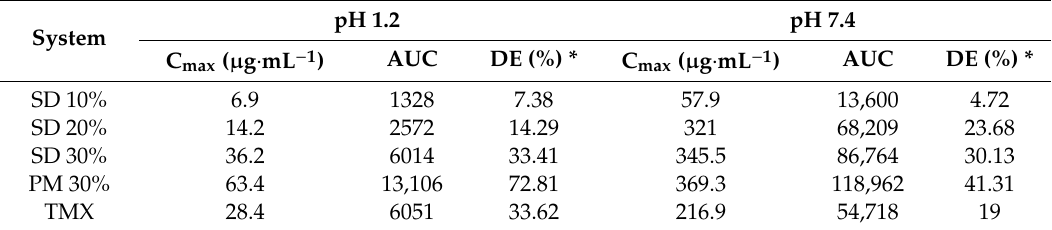
Table 1. Maximum concentration (C max ), area under the curve (AUC), and DE (%) obtained by the dissolution of each system in pH 1.2 and